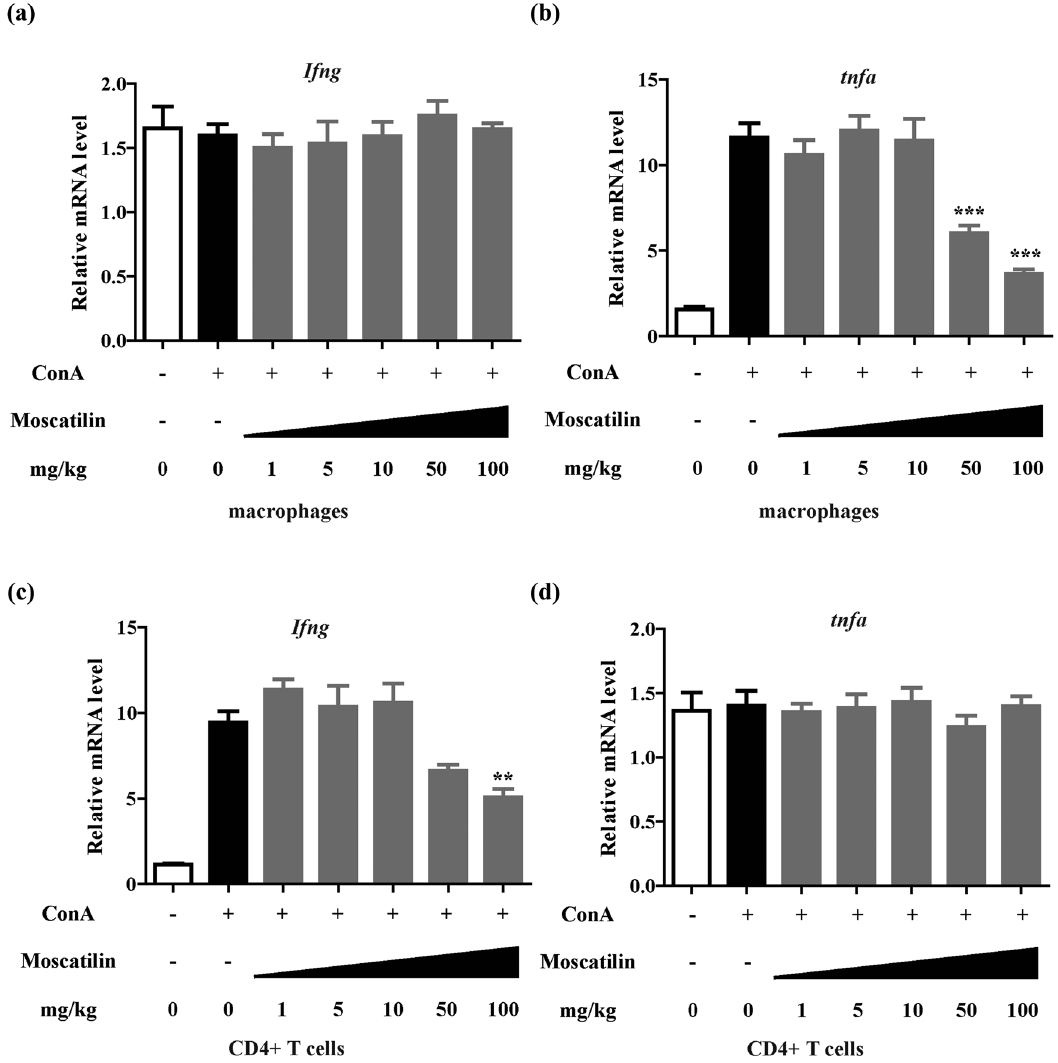
Figure 3: Moscatilin suppresses the IFN - γ expression from CD4 + T cells and TNF - α expression in macrophages. ( a and b ) Macrophages were isolated from liver tissues 24 h after the ConA injury and the mRNA expression of Ifng ( a ) and Tnfa ( b ) genes was detected by real - time RT - PCR. Each group contained 5 samples and *** indicated p value less than 0.001 compared to the ConA group. ( c and d ) CD4 + T cells were isolated from liver tissues 24 h after the ConA injury and the mRNA expression of Ifng ( c ) and Tnfa ( d ) genes was detected by real - time RT - PCR. Each group contained 5 samples and ** indicated p value less than 0.01 compared to the ConA